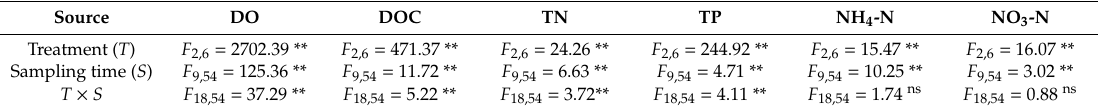
Table 1. Repeated measures ANOVA results for the effects of treatments ( T. orientalis treatment, P. australis treatment, and control) and sampling time (days 0, 1, 3, 5, 10, 15, 30, 60, 90, and 120) on water quality indices, including dissolved oxygen (DO), dissolved organic carbon (DOC), total nitrogen (TN), total phosphorus (TP), ammonium nitrogen (NH 4 -N), and nitrate nitrogen (NO 3 -N). Source DO DOC TN TP NH 4 -N NO 3 -N Treatment ( T ) F 2,6 = 2702.39 ** F 2,6 = 471.37 ** F 2,6 = 24.26 ** F 2,6 = 244.92 **